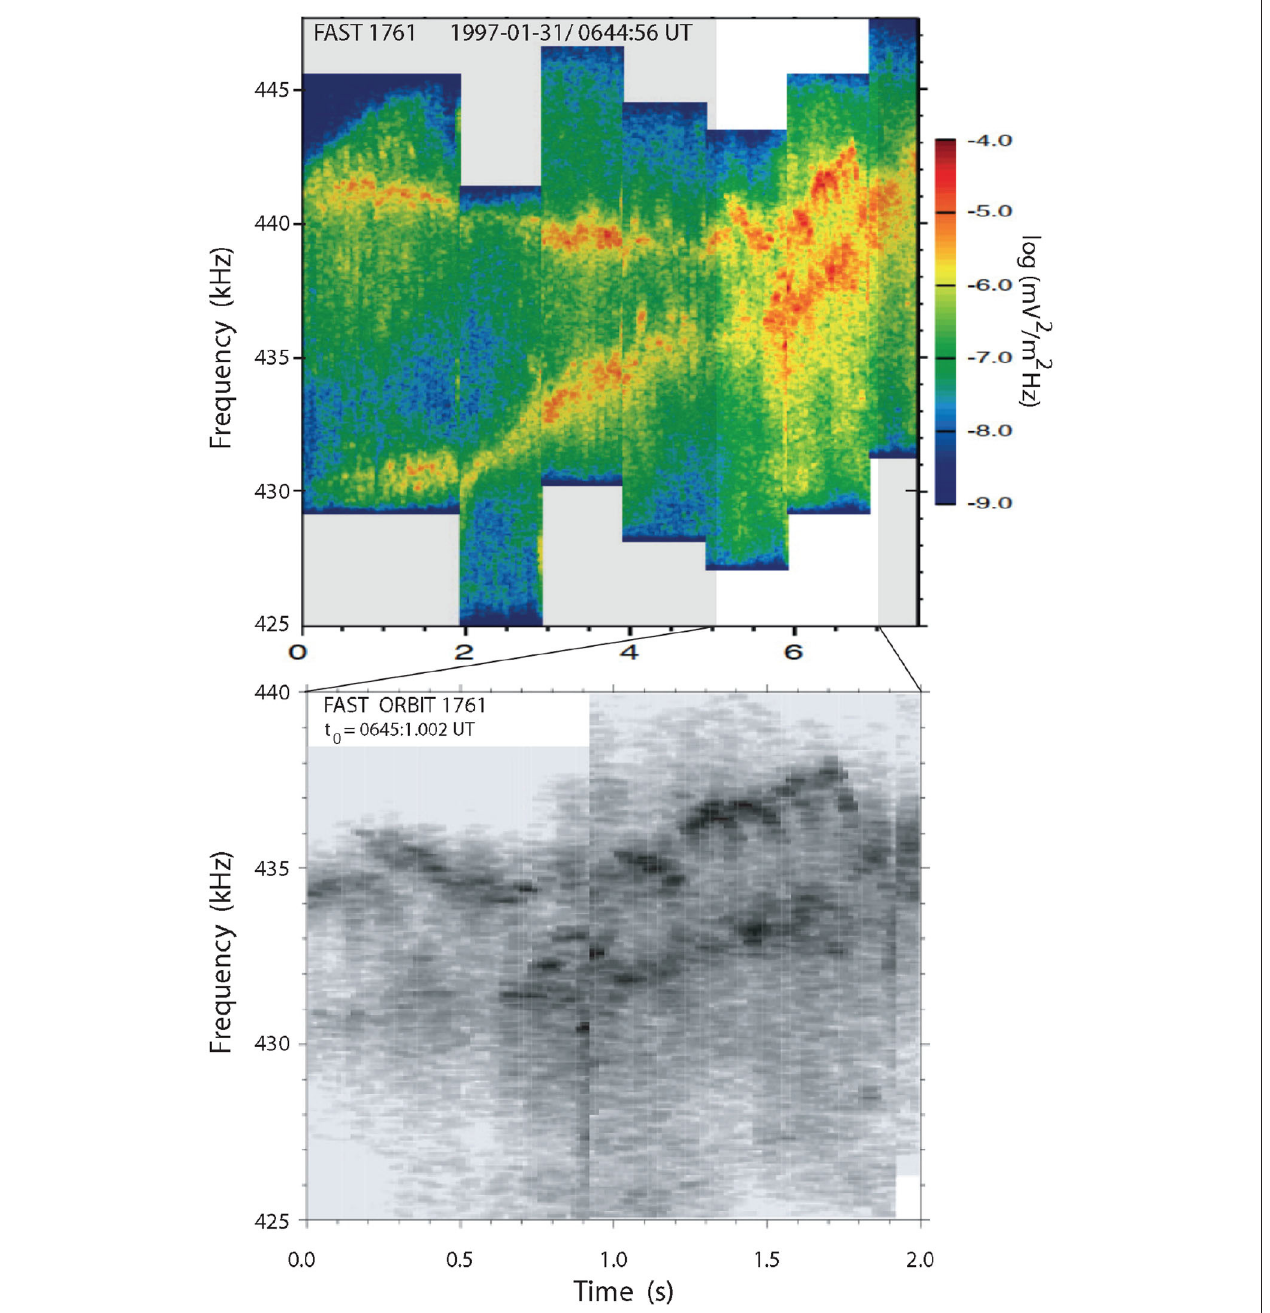
FIGURE 1 | Fine structure in auroral kilometric radiation FAST observations (Figure adopted from [25]). Top : two narrow bands of intense and highly temporally structured drifting auroral kilometric emissions. The bandwidth is of the order of a few kHz only. Upward drift of the bands implies downward motion of the source into the stronger ambient magnetic field region. Obviously each band consists of many separate short emission events. Bottom : High temporal resolution of the indicated available time interval clearly showing the superposition of the many microscopic radiation events which make up the two radiation bands. Each event moves first upward in frequency (sources moves downward in space), then turns around and moves back upward. Emission is strongest in the turn-around (reflection).